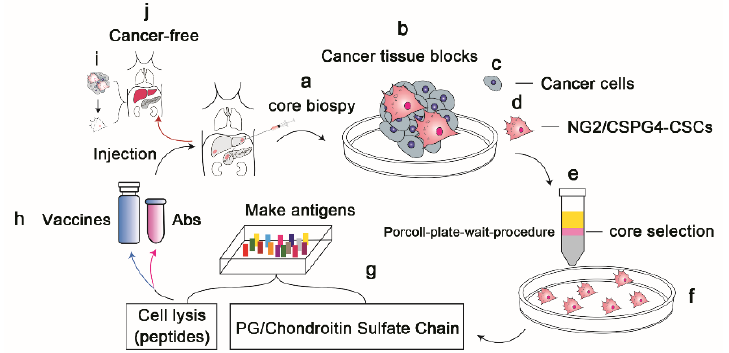
Figure 1. A novel strategy for developing vaccine- or antibody-based therapeutic approaches to target NG2/CSPG4-expressing membrane or cancer stem cells (CSCs) in solid organ cancers. ( a , b ) Core needle biopsies ( a ) and obtained tissue blocks ( b ) from solid organ (liver, pancreas, lungs, or kidneys) cancers. ( c , d ) The obtained cancer tissue blocks contained both cancer cells ( c ) and NG2/CSPG4-expressing cells ( d ), defined as CSCs. ( e , f ) Use of a unique method, the “Percoll − Plate − Wait procedure”, as the core selection method to purify NG2/CSPG4-expressing cells from the blocks and expand them in cultures ( f – j ) Use of the purified NG2/CSPG4-expressing cells to produce different antigen types, either cell lysates (peptides) or PG/chondroitin sulfate chain membranes ( g ), as vaccine or antibody targets ( h ) to eliminate NG2/CSPG4-expressing cells (such as CSCs). The cancer mass ultimately regressed ( i ), creating a population of cancer-free patients that received (injection) vaccines or antibodies ( j ).